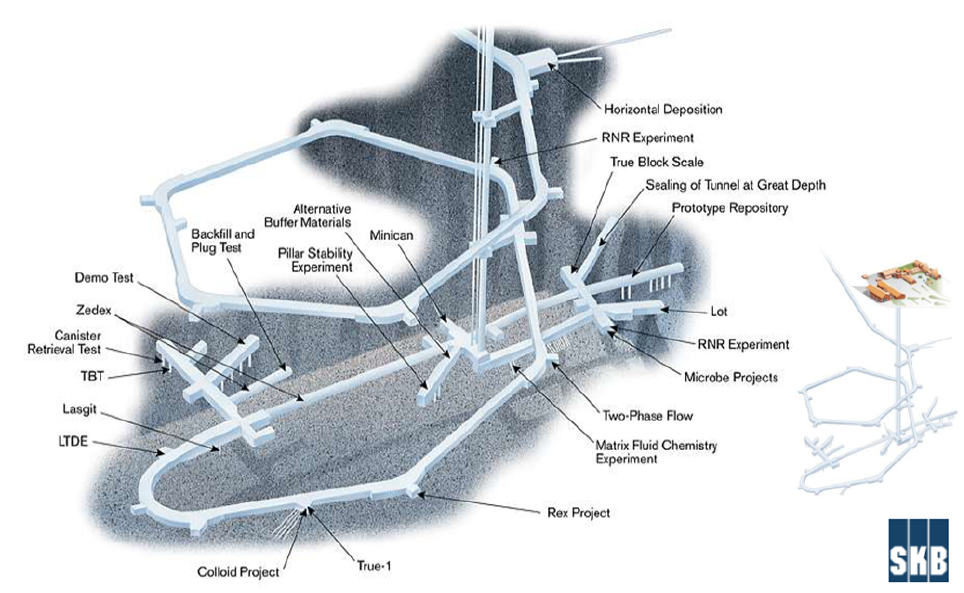
Figure 1: The underground test installations in the ¨Asp¨o Hard Rock laboratory including names of major